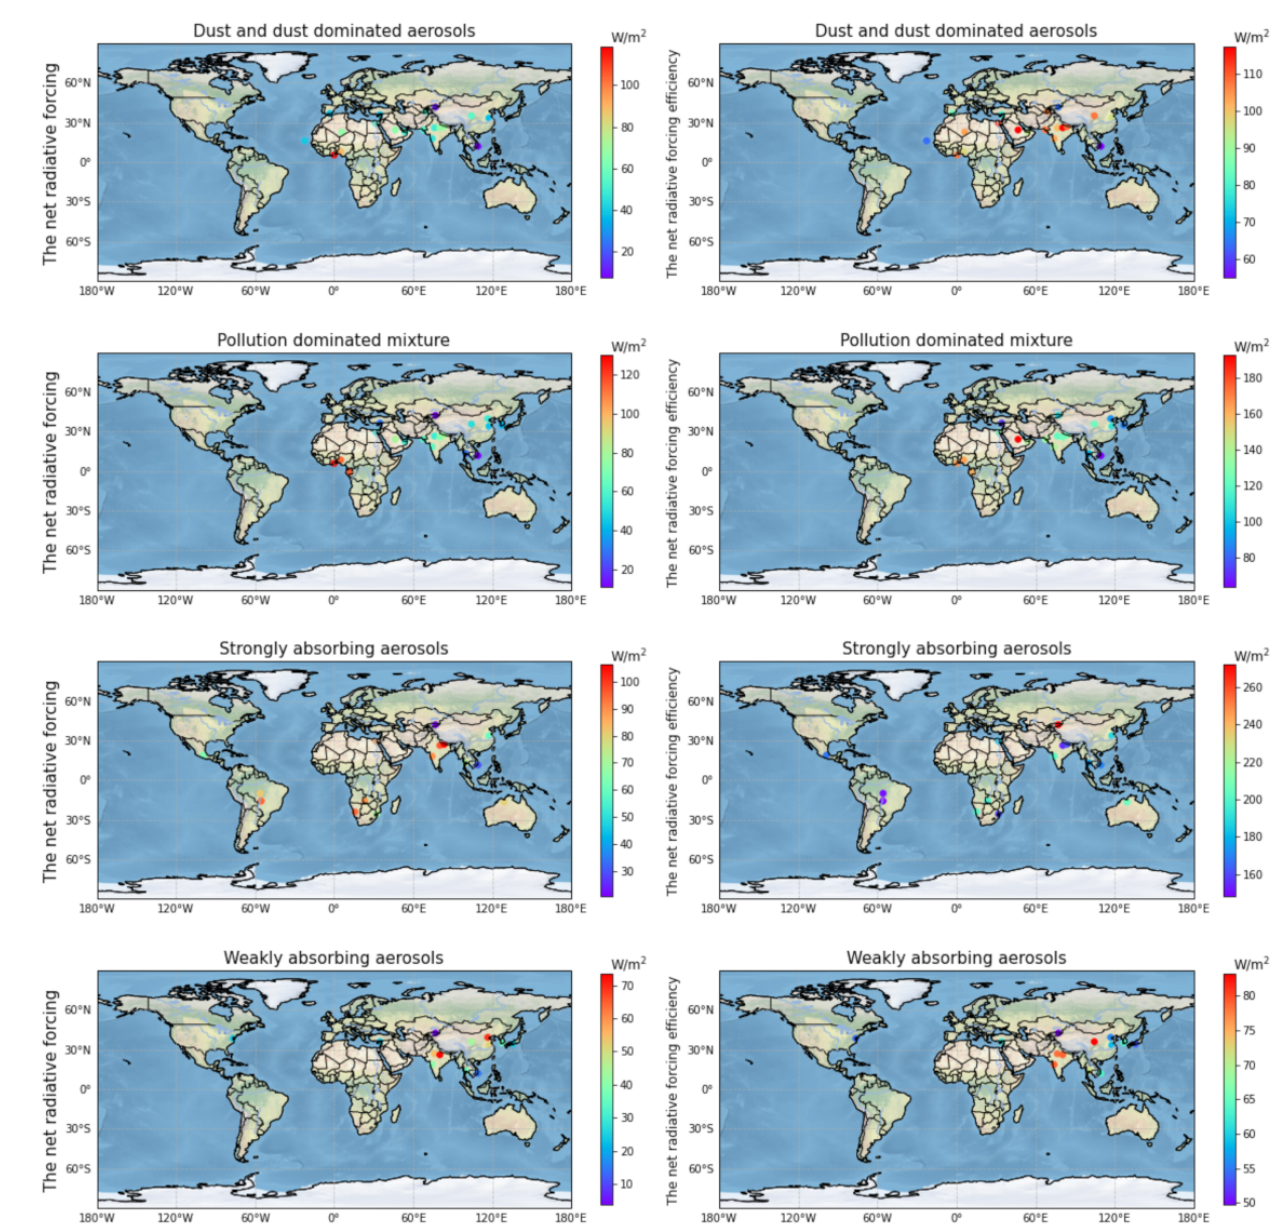
Figure 8. The net radiative forcing and radiative forcing efficiency for each kind of aerosol (dust and dust dominated aerosols, pollution dominated mixture, strongly absorbing aerosols, weakly absorbing aerosols), the color dot in each site means the mean values of net radiative forcing or the net radiative forcing